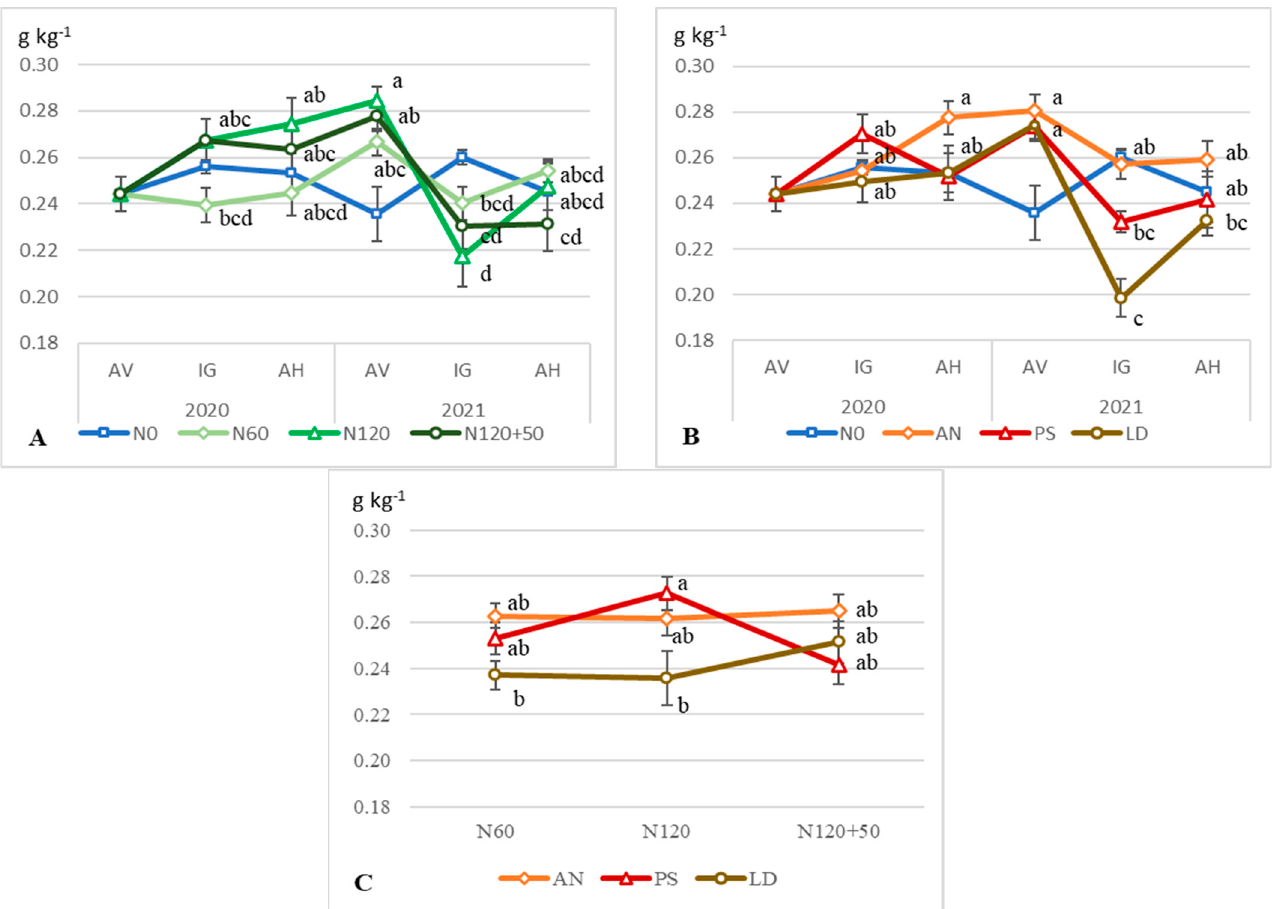
Figure 2. Variation in soil water-extractable organic carbon (WEOC) (0–30 cm) during winter wheat growing season as influenced by different nitrogen rates ( A ), fertilizers ( B ), and their interactions ( C ). The standard error ( SE ) of the mean is used to represent error bars. Means with different letters within individual interactions are significantly different at the p < 0.05 level (N0 and AV2020 values are not included in the calculations; the letters are only implied). Abbreviations. Soil collection time: AV, at the beginning of winter wheat vegetation; IG, during intensive winter wheat growing (~1.5 months after AV and fertilization); AH, after winter wheat harvest. Nitrogen (N) rates: N0, unfertilized; N60, 60 kg N·ha − 1 rate; N120, 120 kg N·ha − 1 rate; N120+50, 120 + 50 kg N·ha − 1 rate. Fertilizers: N0, unfertilized; AN, ammonium nitrate; PS, pig slurry; LD, liquid anaerobic digestate.